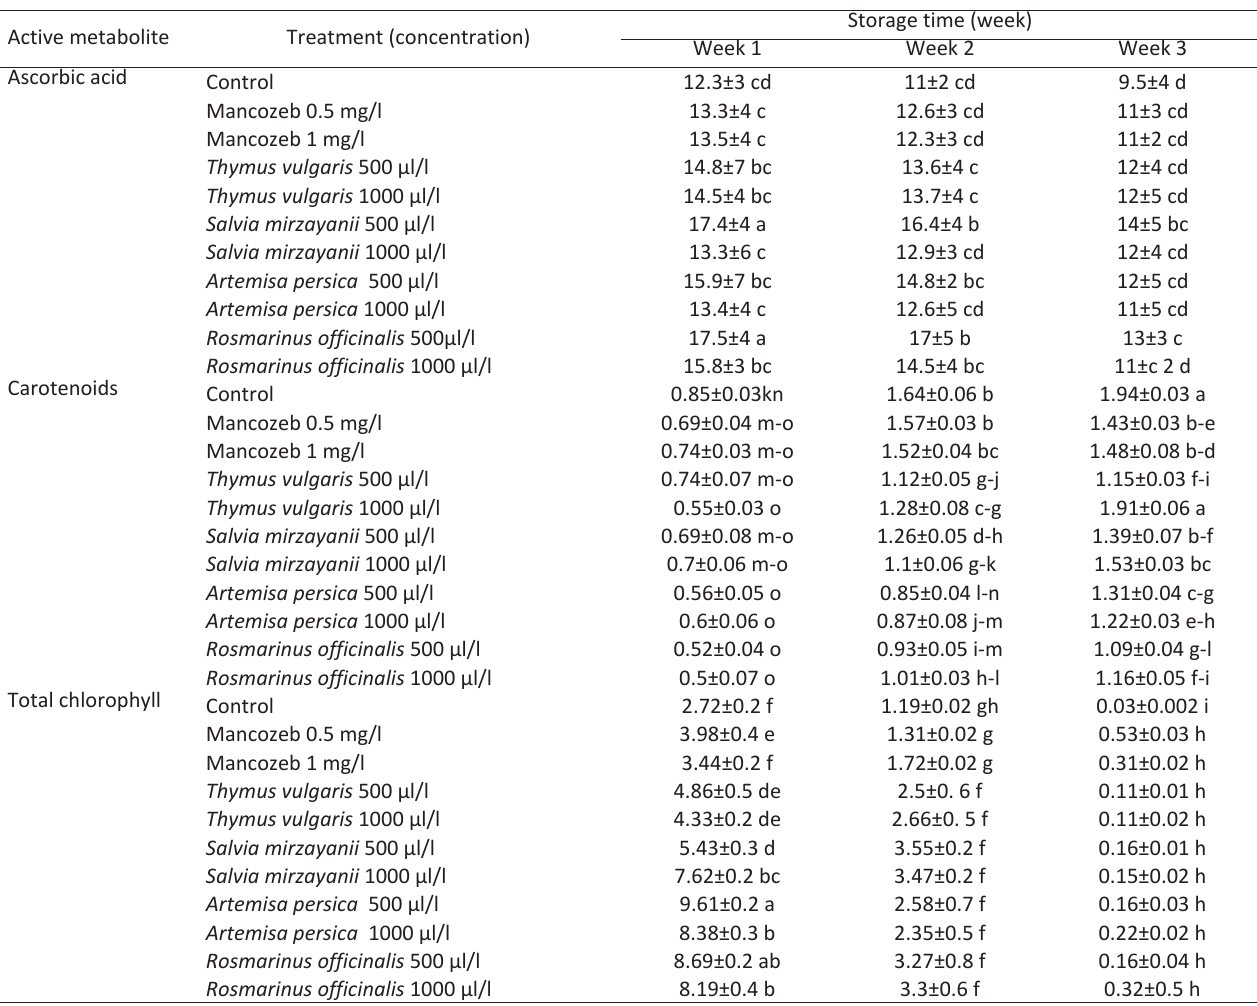
Table 2 - Effect of the Thymus vulgaris , Salvia mirzayanii , Artemisia persica and Rosmarinus officinalis EOs tested at 500 and 1000 μl/l on the ascorbic acid, carotenoids and total chlorophyll content ± SD in mangos after 1, 2, and 3 weeks of storage compared to ‘mancozed’ (0.5 and 1.0